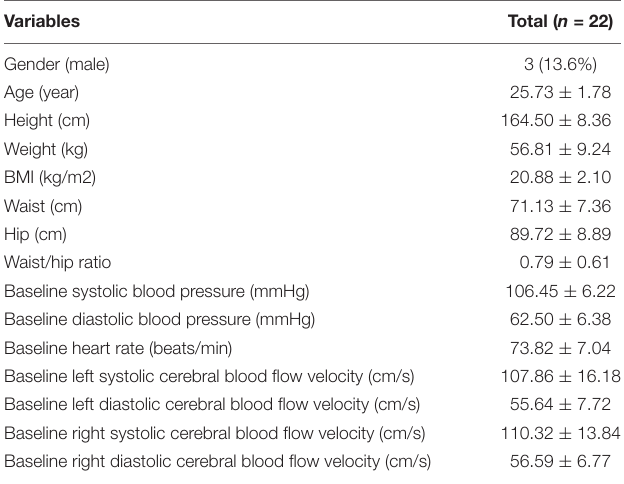
TABLE 1 | Clinical characteristics of study